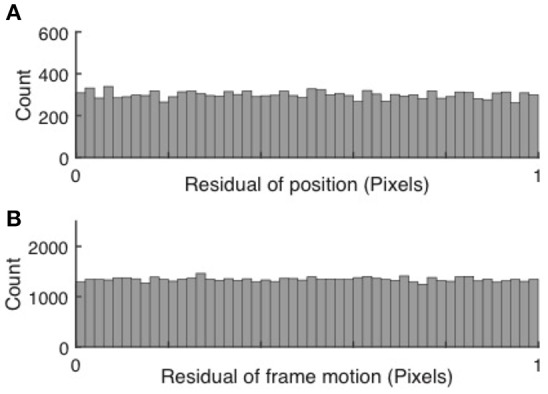
Validation of subpixel resolution particle finding and motion correction. (A) Distribution of the residual cell position after extraction for 67,148 cells extracted from 15,000 frames. (B) Distribution of the frame-to-frame residual displacement. The uniform distributions indicate sub-pixel resolution of both cell tracking and motion correction.